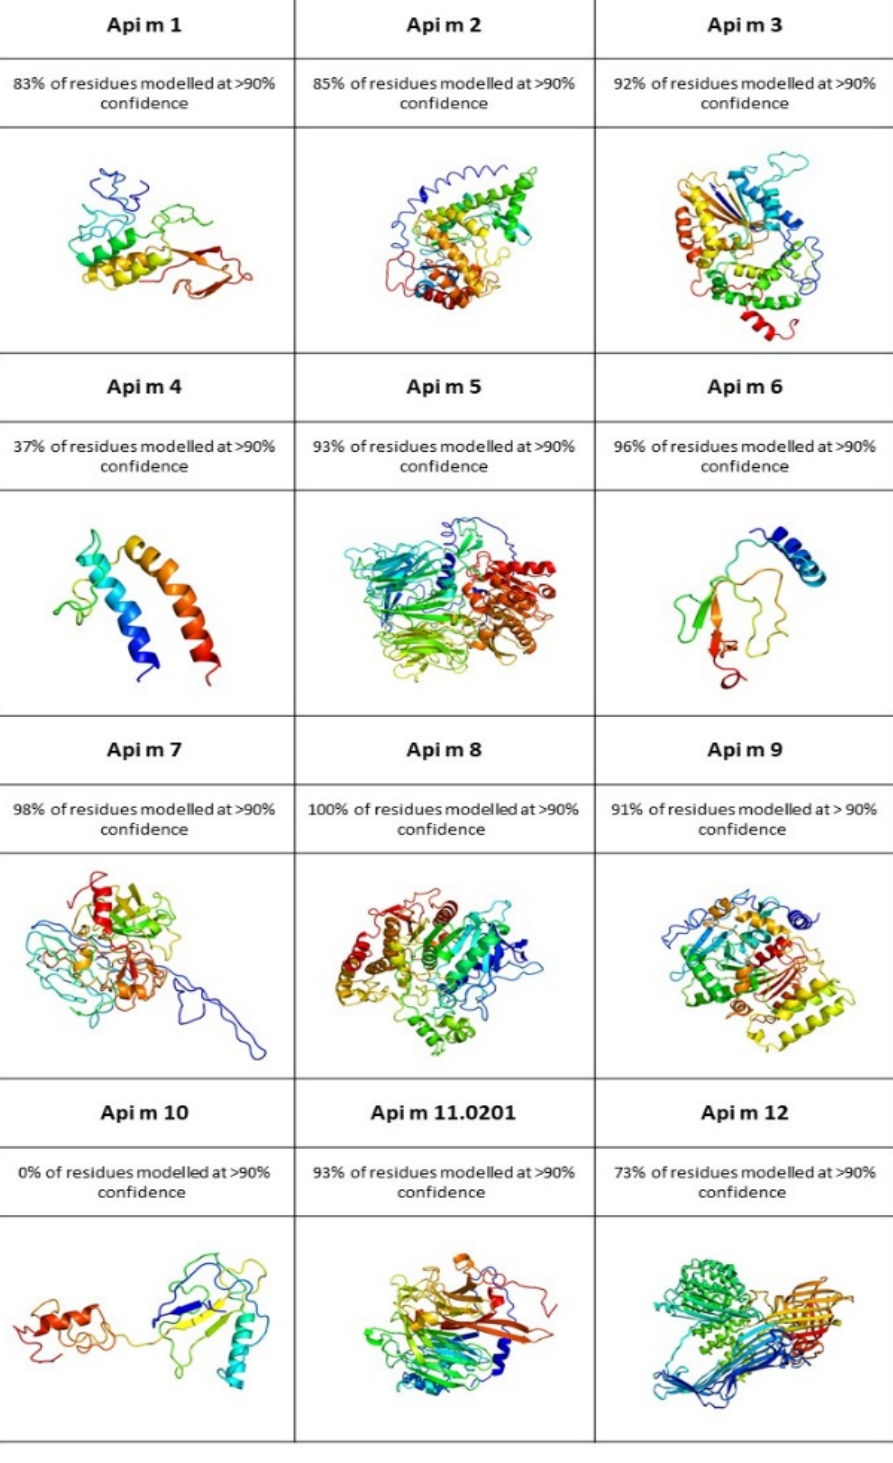
Figure 1. Structural features of selected Hymenoptera venom allergens. Three-dimensional structures of all HBV, 100.0%–90.0% confidence by the single highest scoring template, Image rainbow-colouring from N to (C-terminus). The structures were generated by structural modelling (PHYRE2 server [60,61]).